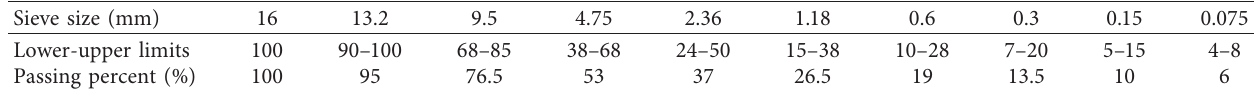
Table 6: Gradation of the aggregates.